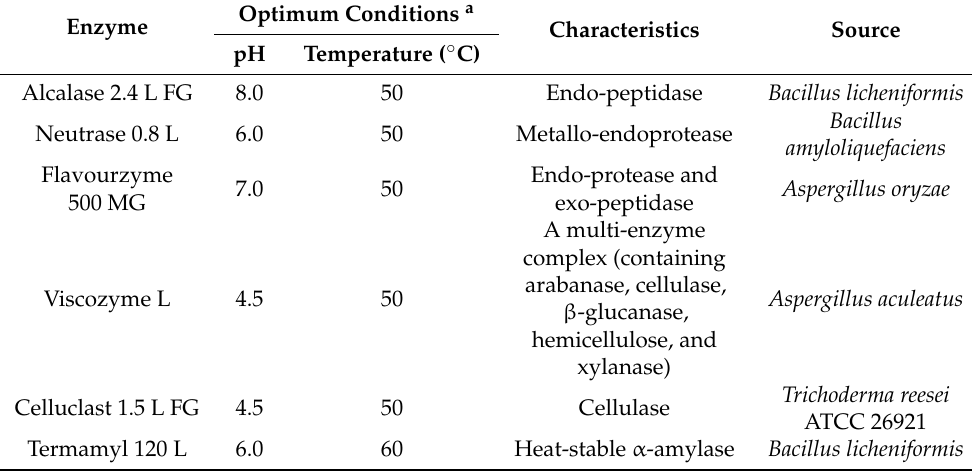
Table 1. Summary of the optimum hydrolysis conditions, characteristics, and sources of specific enzymes used in this